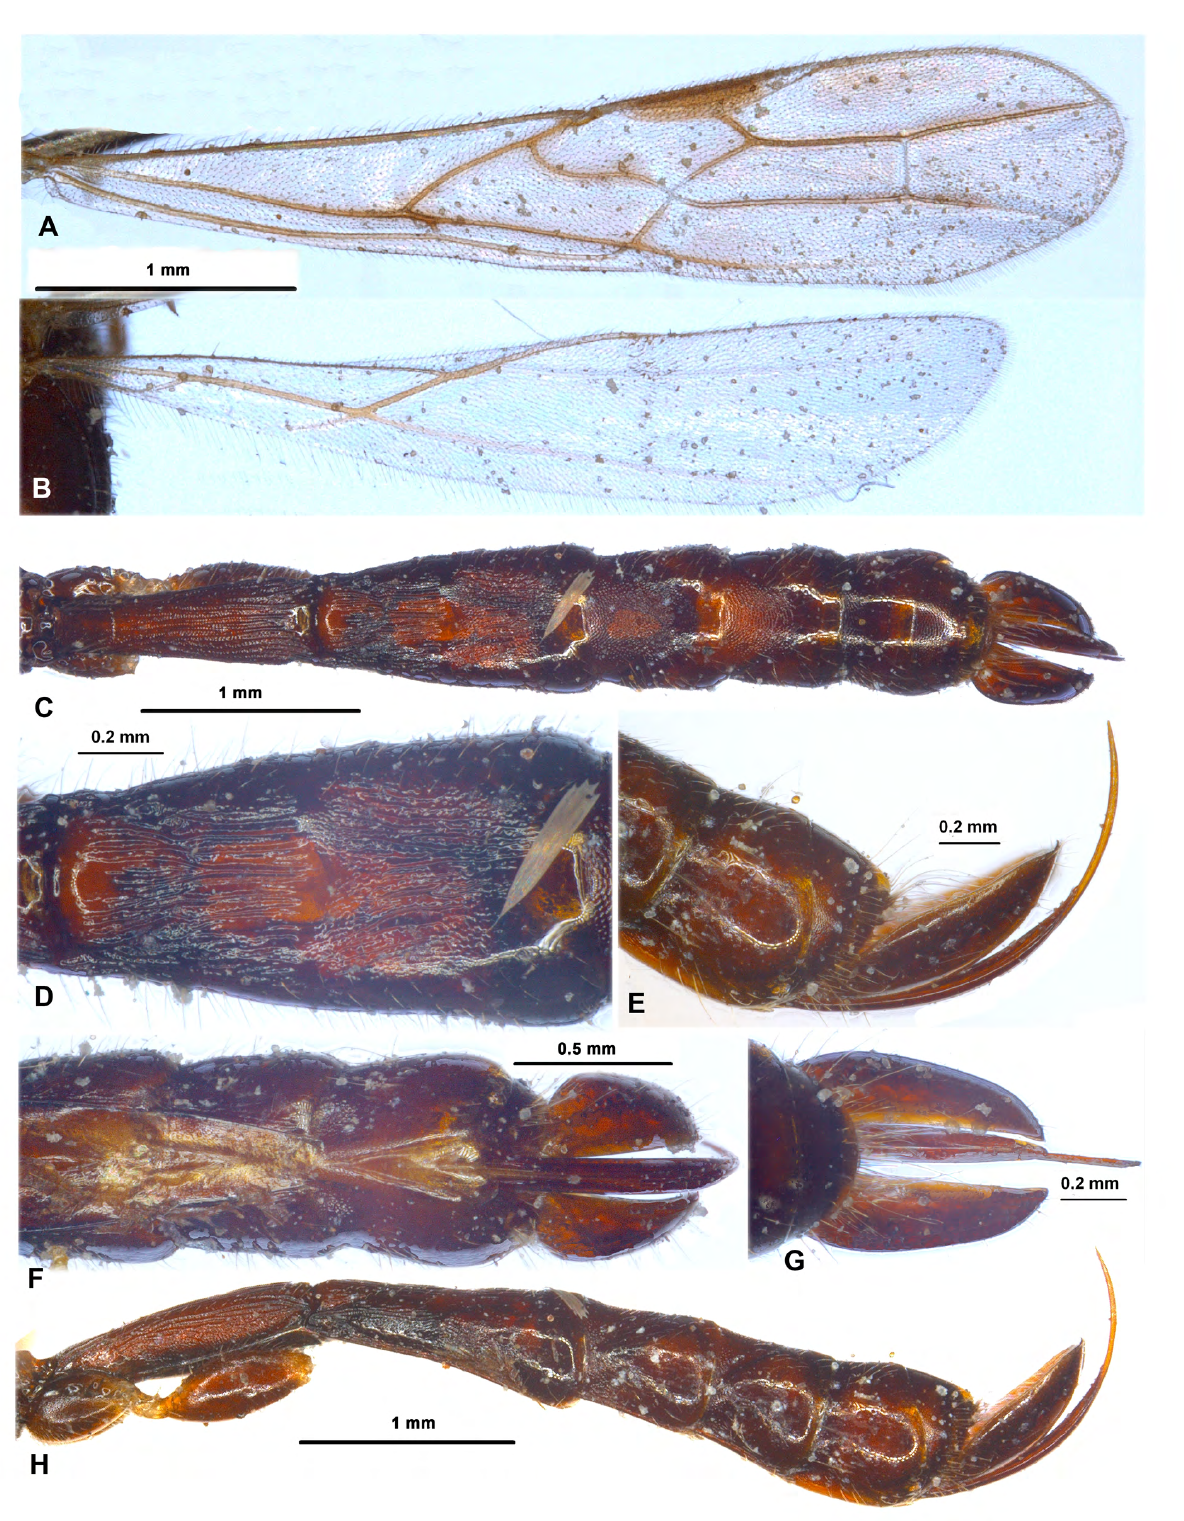
Fig. 23. Leptorhaconotus brunneus Granger, 1949, ♀, holotype, MNHN. A . Fore wing. B . Hind wing. C . Metasoma, dorsal view. D . Second and third metasomal tergites, dorsal view. E . Apex of metasoma and ovipositor with sheaths, lateral view. F . Apex of metasoma and ovipositor with sheaths, ventral view. G . Ovipositor with sheaths, dorsal view. H . Metasoma, lateral